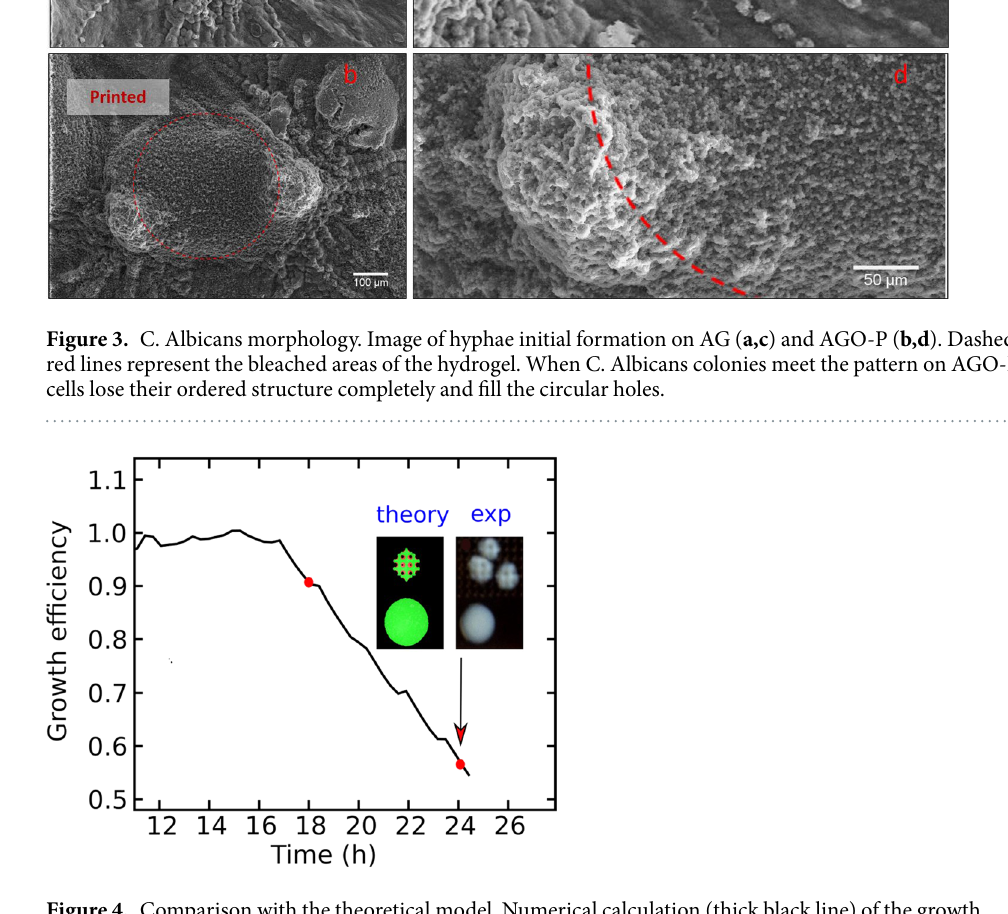
Figure 4. Comparison with the theoretical model. Numerical calculation (thick black line) of the growth efficiency and comparison with experimental results (red dots). The insets show growing cells in an unstructured (bottom picture) and structured (top picture) environment. The experimental results in the insets refer to E. Coli after 24